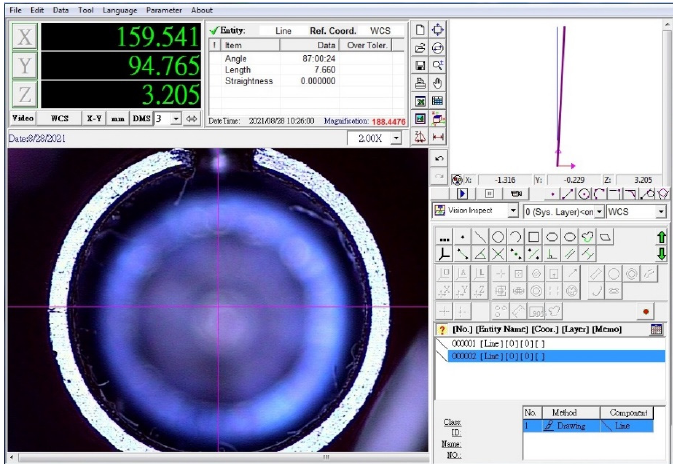
Figure 3. Evaluation of rotational misfit using video measuring machine.